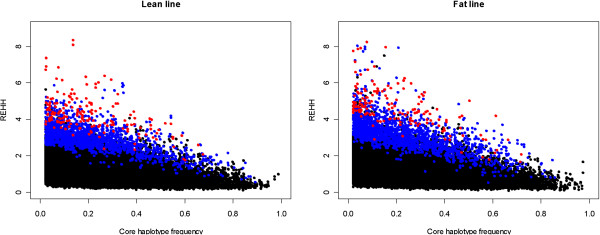
Distribution of REHH vs. core haplotype frequencies in the lean and fat lines. Core haplotypes with P-values lower than 0.05 and 0.01 are presented in blue and red, respectively.